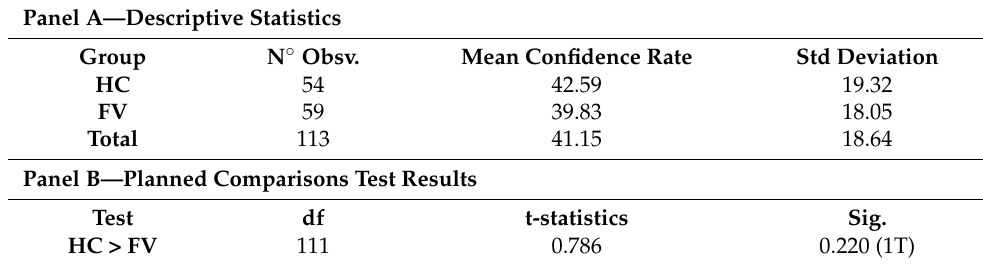
Table 4. Analysis of Confidence about Future Performance.